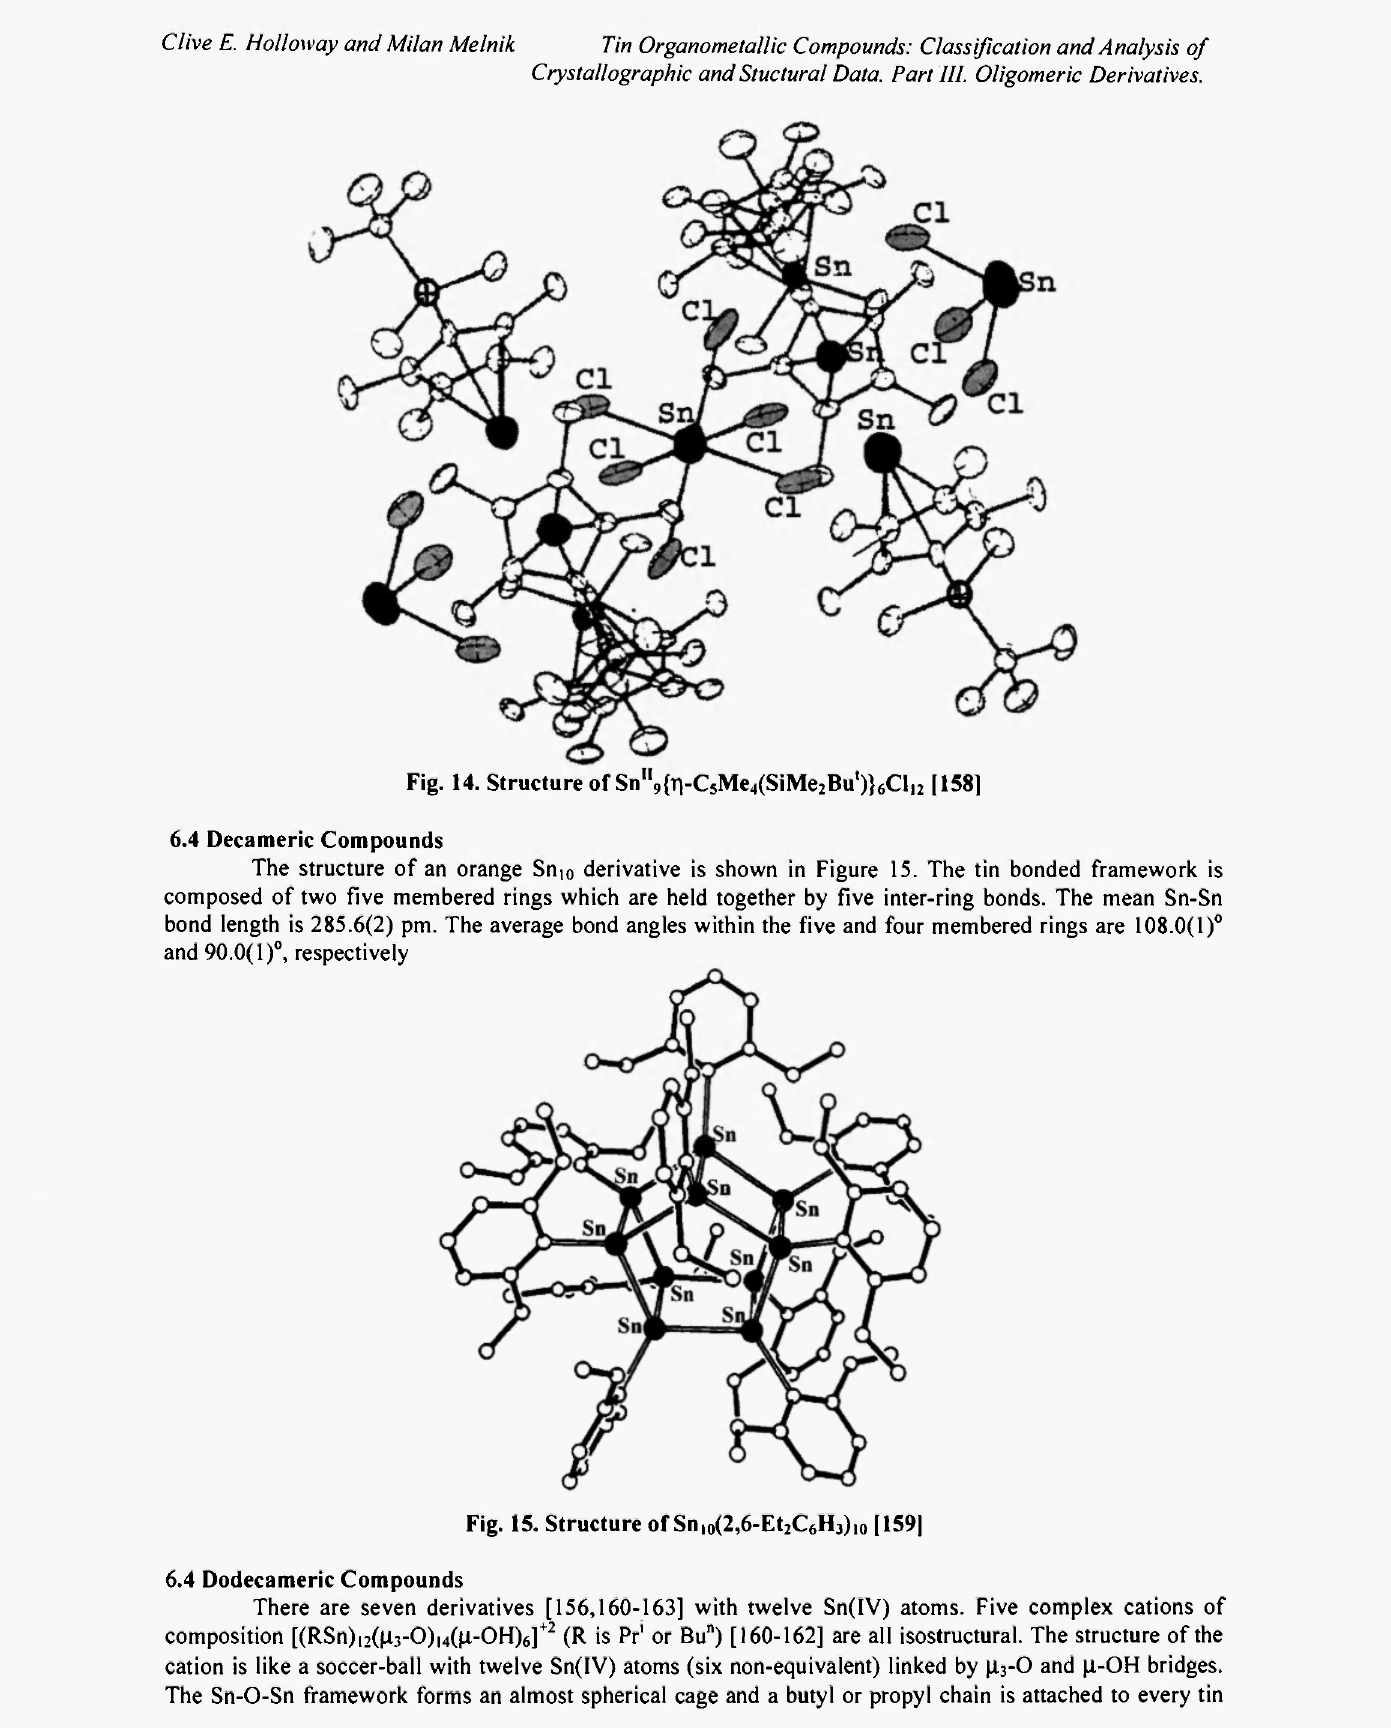
Fig. 15. Structure of Sn,o(2,6-Et2C 6 H3) 10